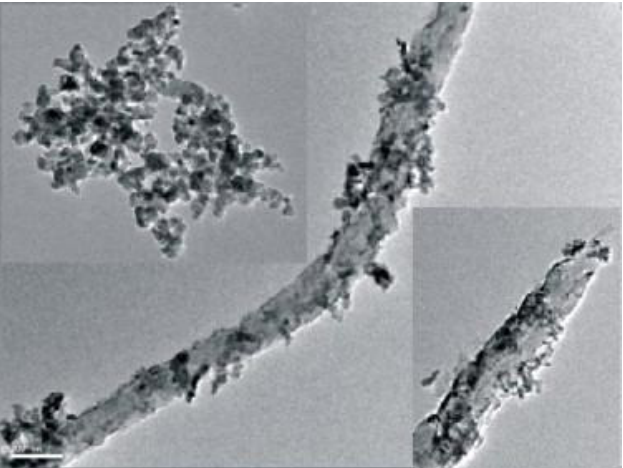
Figure 16. TEM images of CZA supported on multi-walled carbon nanotubes pretreated with a H 2 SO 4 /HNO 3 mixture. Reprinted from Appl. Surf. Sci. , 285, Zha, F.; Tian, H.; Yan, J.; Chang, Y., Multi- Walled Carbon Nanotubes as Catalyst Promoter for Dimethyl Ether Synthesis from CO 2 Hydrogenation, 945–951. Copyright (2013) with permission from